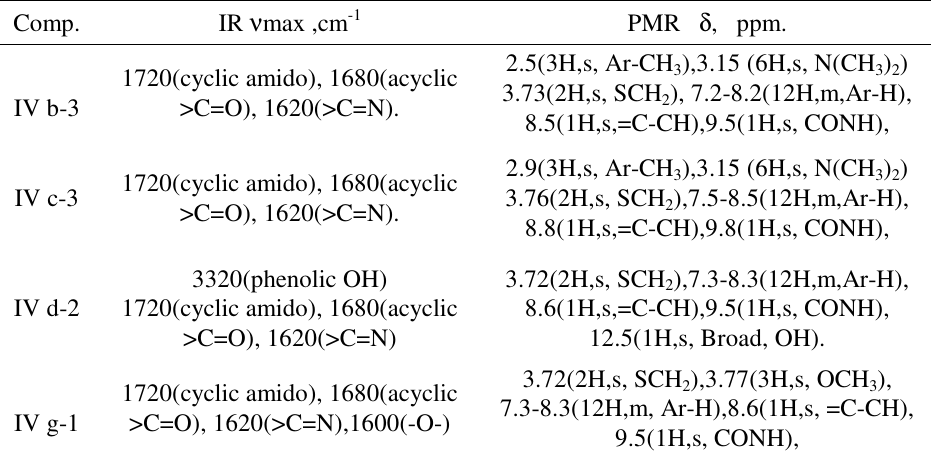
Table 6. Spectral